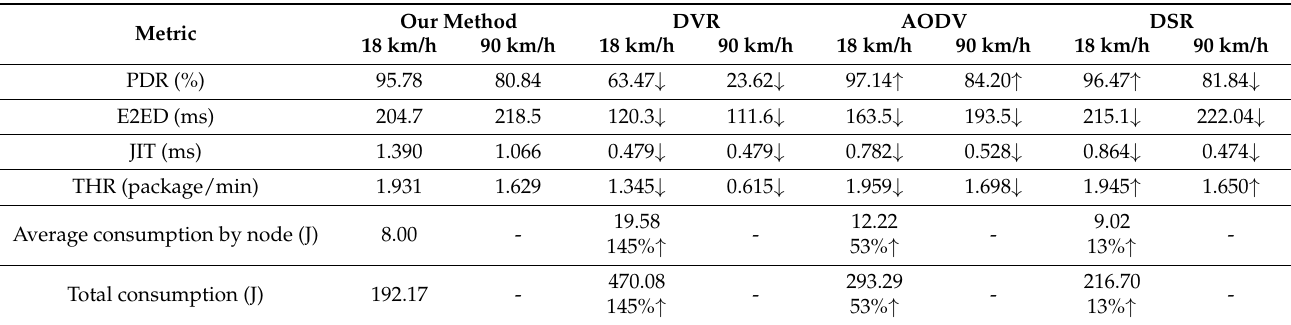
Table 2. Comparative analysis for DVR, AODV, DSR, and modified DSR